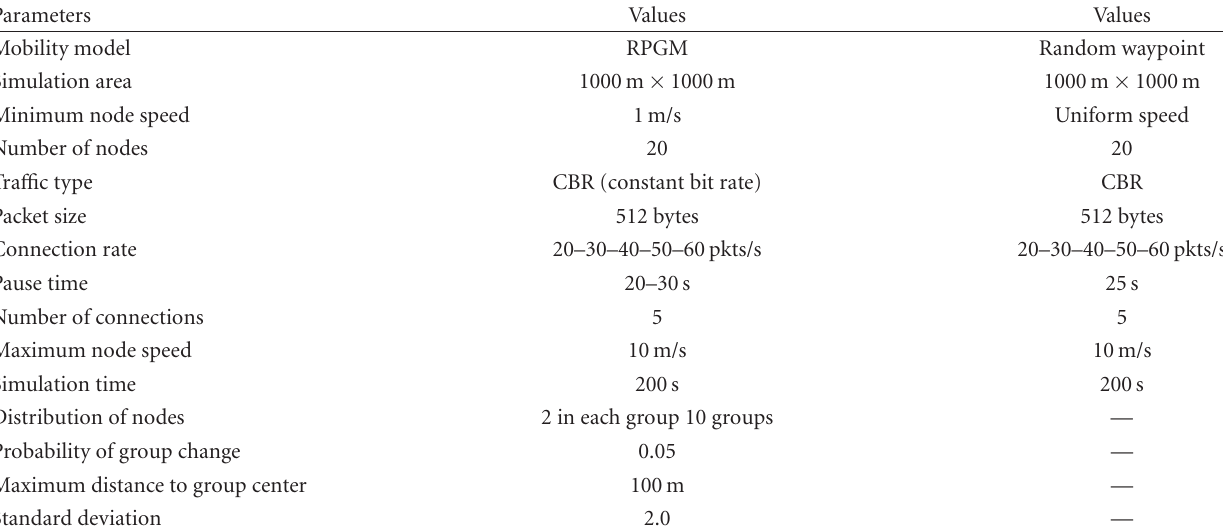
Table 3: Parameters for RPGM and random waypoint-network